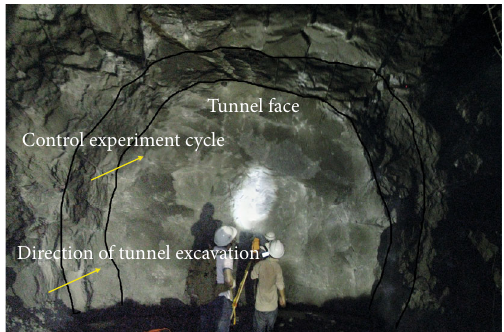
Figure 14: Overall e ff ect of tunnel smooth